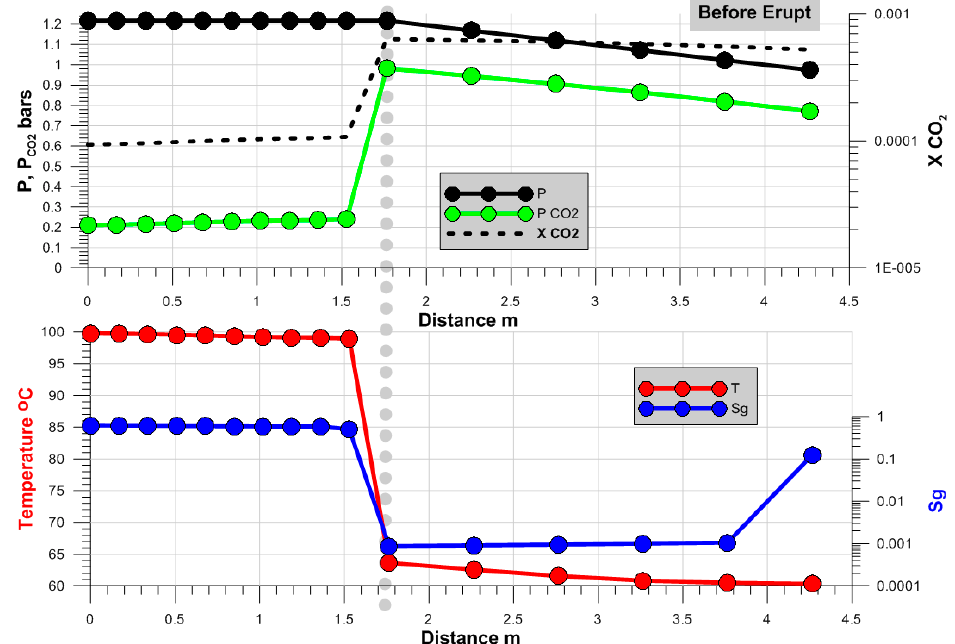
Figure 12. Modeling (run #9A2, unknown parameter estimations were: q = 0.15 kg/s, h = 84 kJ/kg (water 20 °C), Q = 2 kg/s)) of the transient bottom temperature in the Shaman geyser vs. the bottom temperature records obtained during the time period of observations from 27.06.2019 18:00 to 29.06.2019 18:00 (Figure 5).